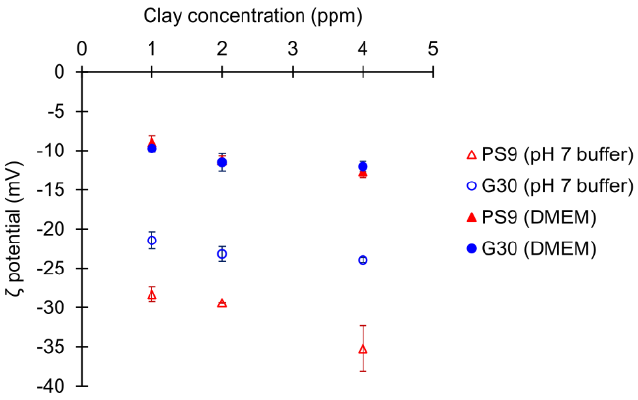
Figure 2. Zeta potential variations of PS9 and G30 (mean values ± s.d.; n = 3) in pH 7 buffer and complete DMEM culture medium at different concentrations.